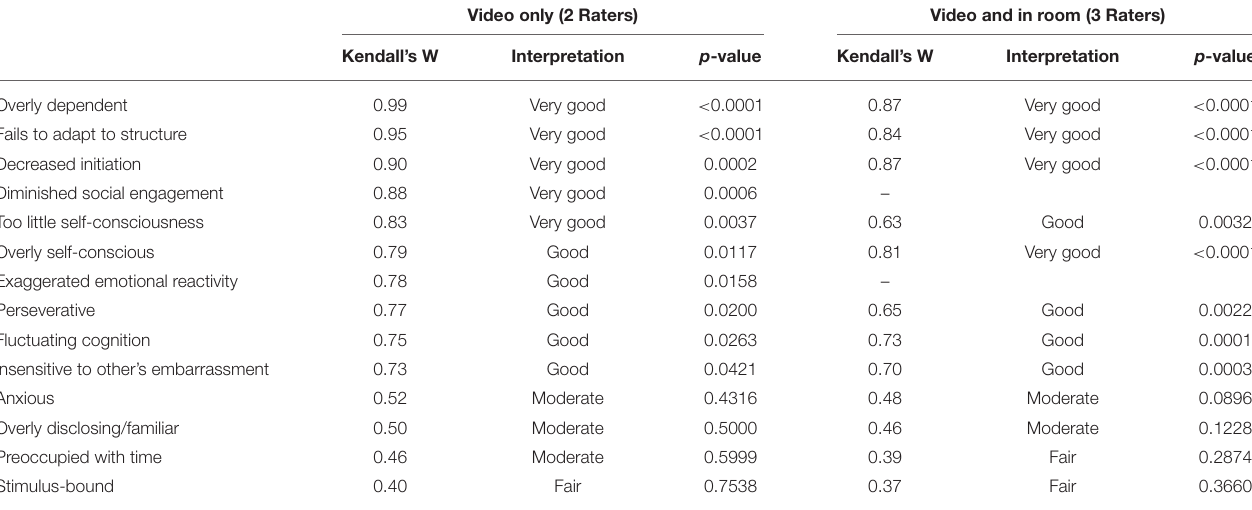
TABLE 4 | Interrater reliability of SBOCL descriptor items rated by non-specialist